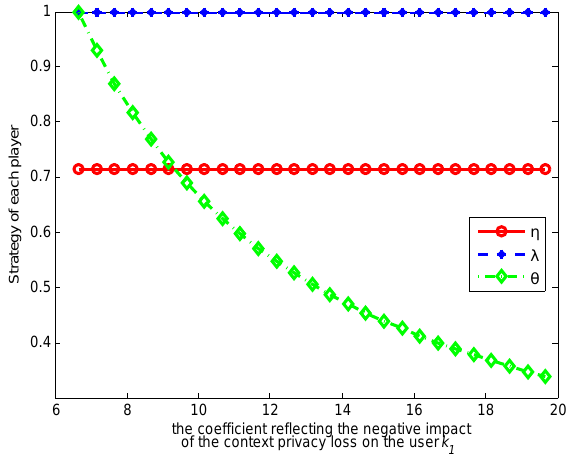
Figure 3. Impact of k 1 on